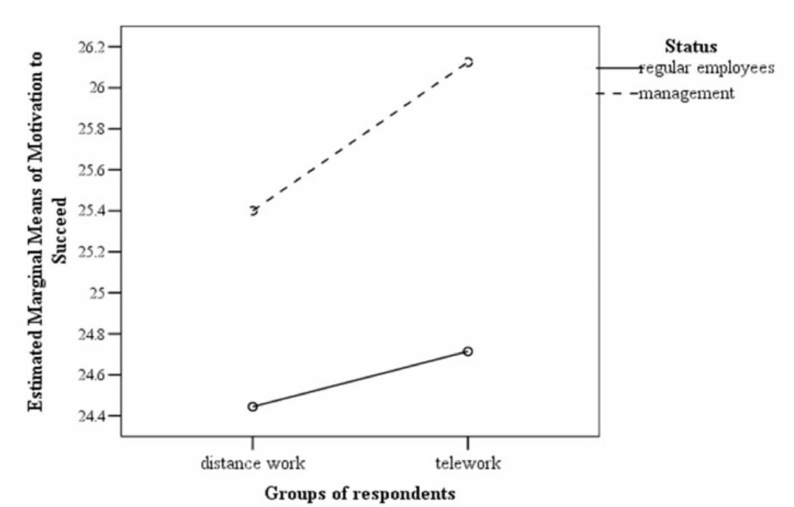
Figure 2: Features of the motivational sphere of employees depending on the position and form of labour